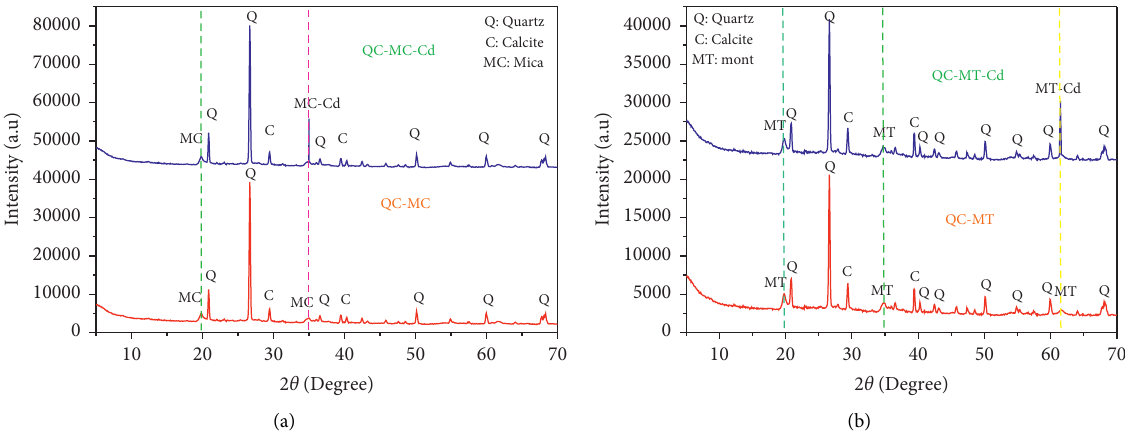
Figure 12: XRD pattern before and after adsorption of Cd (II) by (a) QC-MC and (b)